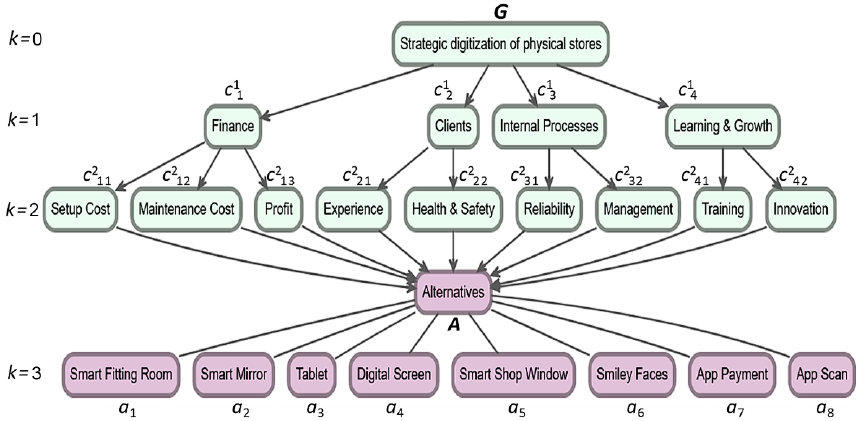
Figure 5. Hierarchy H for strategic digitization of physical